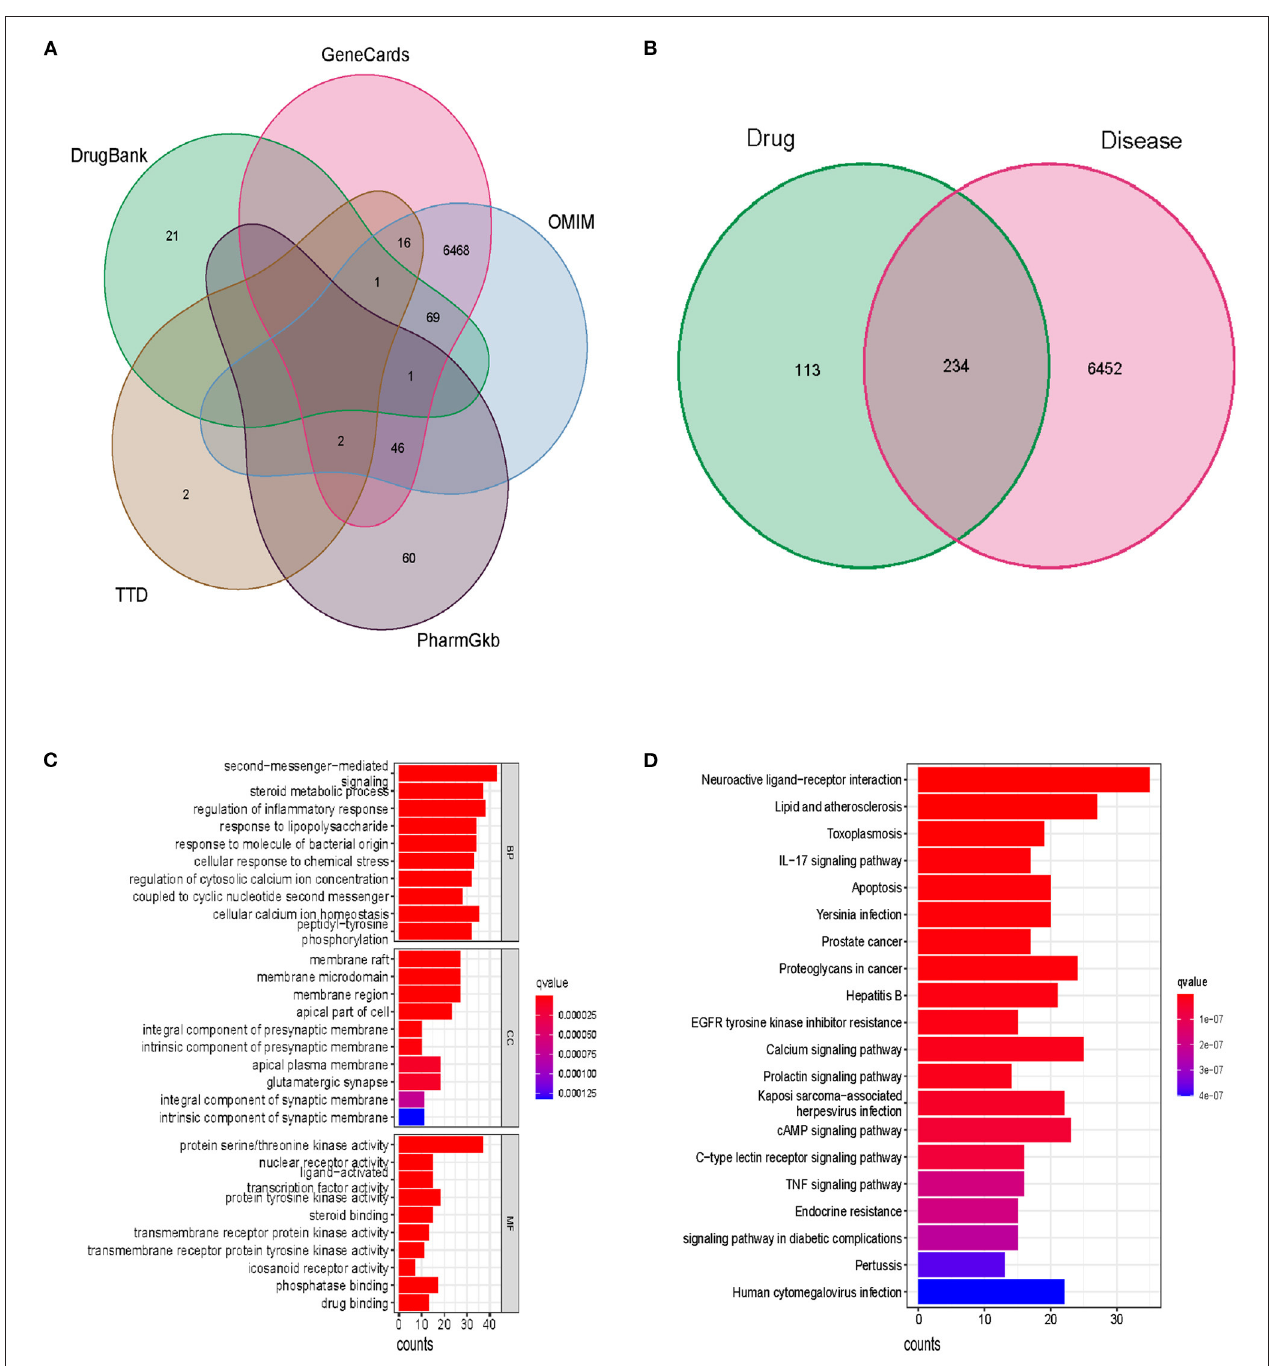
FIGURE 2 | The potential function and pathways of SBP on CAD. (A) Disease genes of CAD from five databases. (B) Genes existing in both drug and disease. (C) Top 10 results of the GO analysis including BP, GC, and MF. (D) Top 30 pathways in which SBP functions in CAD.